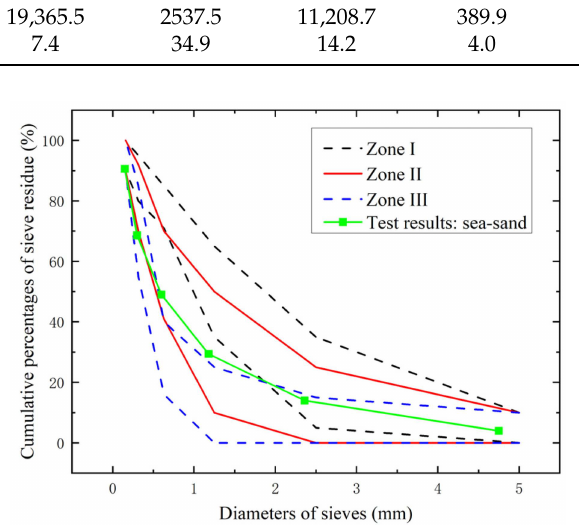
Figure 2. Screening test results of